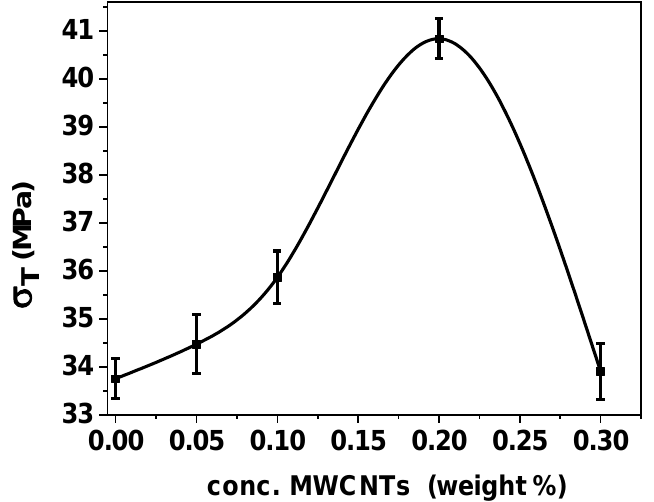
Figure 8. Variation of the maximum of true stress, depending on the concentration of the nano- filler.